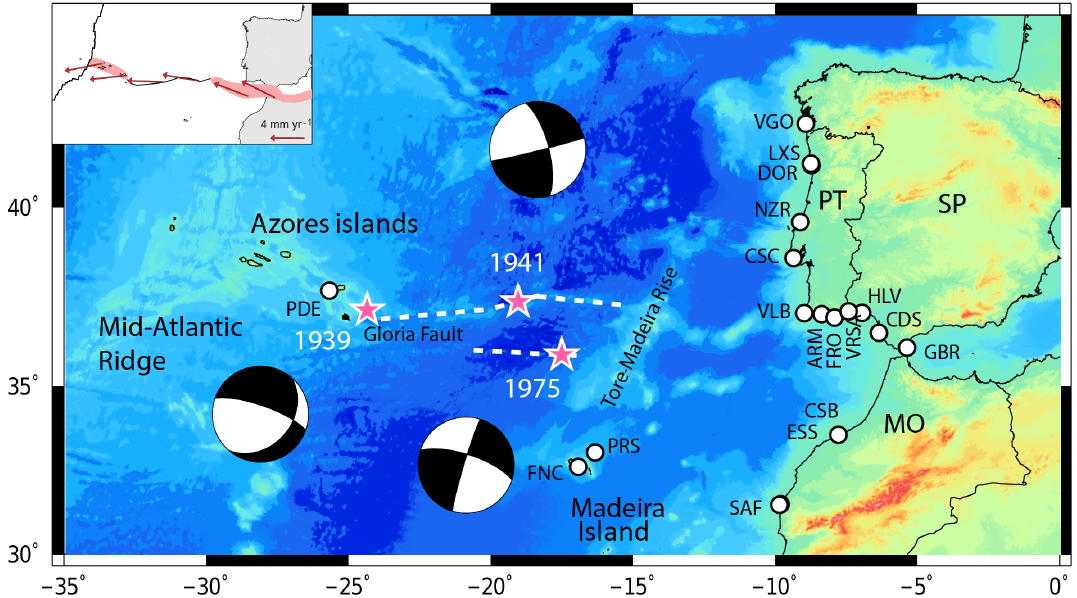
Figure 1. Shaded bathymetry map of Iberia, northwest Africa, and the central Atlantic. The three pink stars correspond to the epicentres of the large strike-slip events in the study area (see text for details). The points of interest used in this study are: VGO (Vigo), LXS (Leixões), DOR (Douro), NZR (Nazaré), CSC (Cascais), VLB (Vila do Bispo), ARM (Armação), FRO (Faro), VRSA (Vila Real de Santo António), HLV (Huelva), CDS (Cádis), GBR (Gibraltar), CSB (Casablanca), ESS (Essaouira), SAF (Safi), PRS (Porto Santo), FNC (Funchal), and PDE (Ponta Delgada). PT (Portugal); SP (Spain); MO (Morocco). Inset shows the relative velocities between Nubian and Eurasia plates. Focal mechanisms for the three largest instrumental earthquakes are also shown according to Table